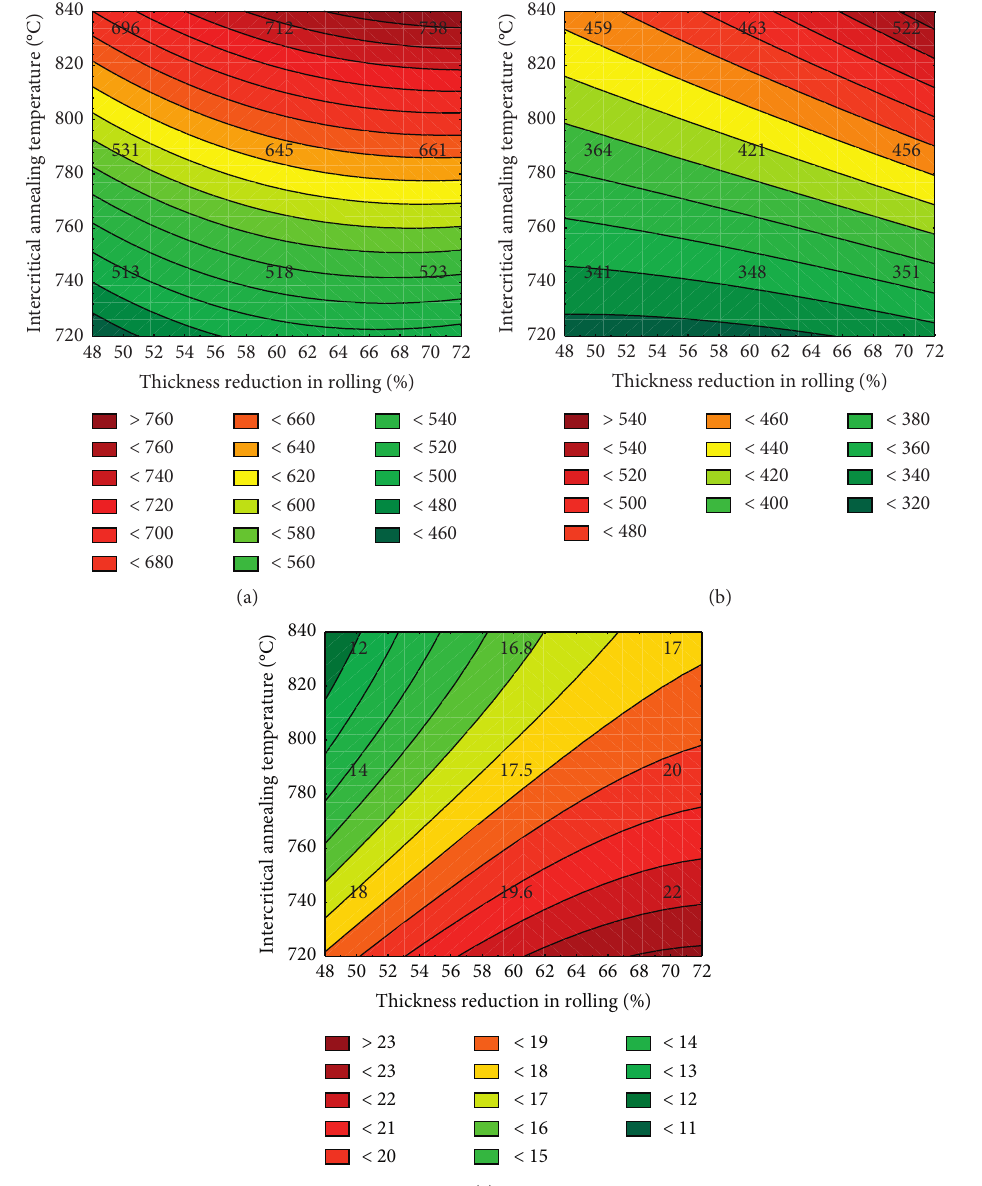
Figure 9: Effects of thickness reduction and intercritical annealing temperature on mechanical properties: (a) UTS; (b) YS; (c)